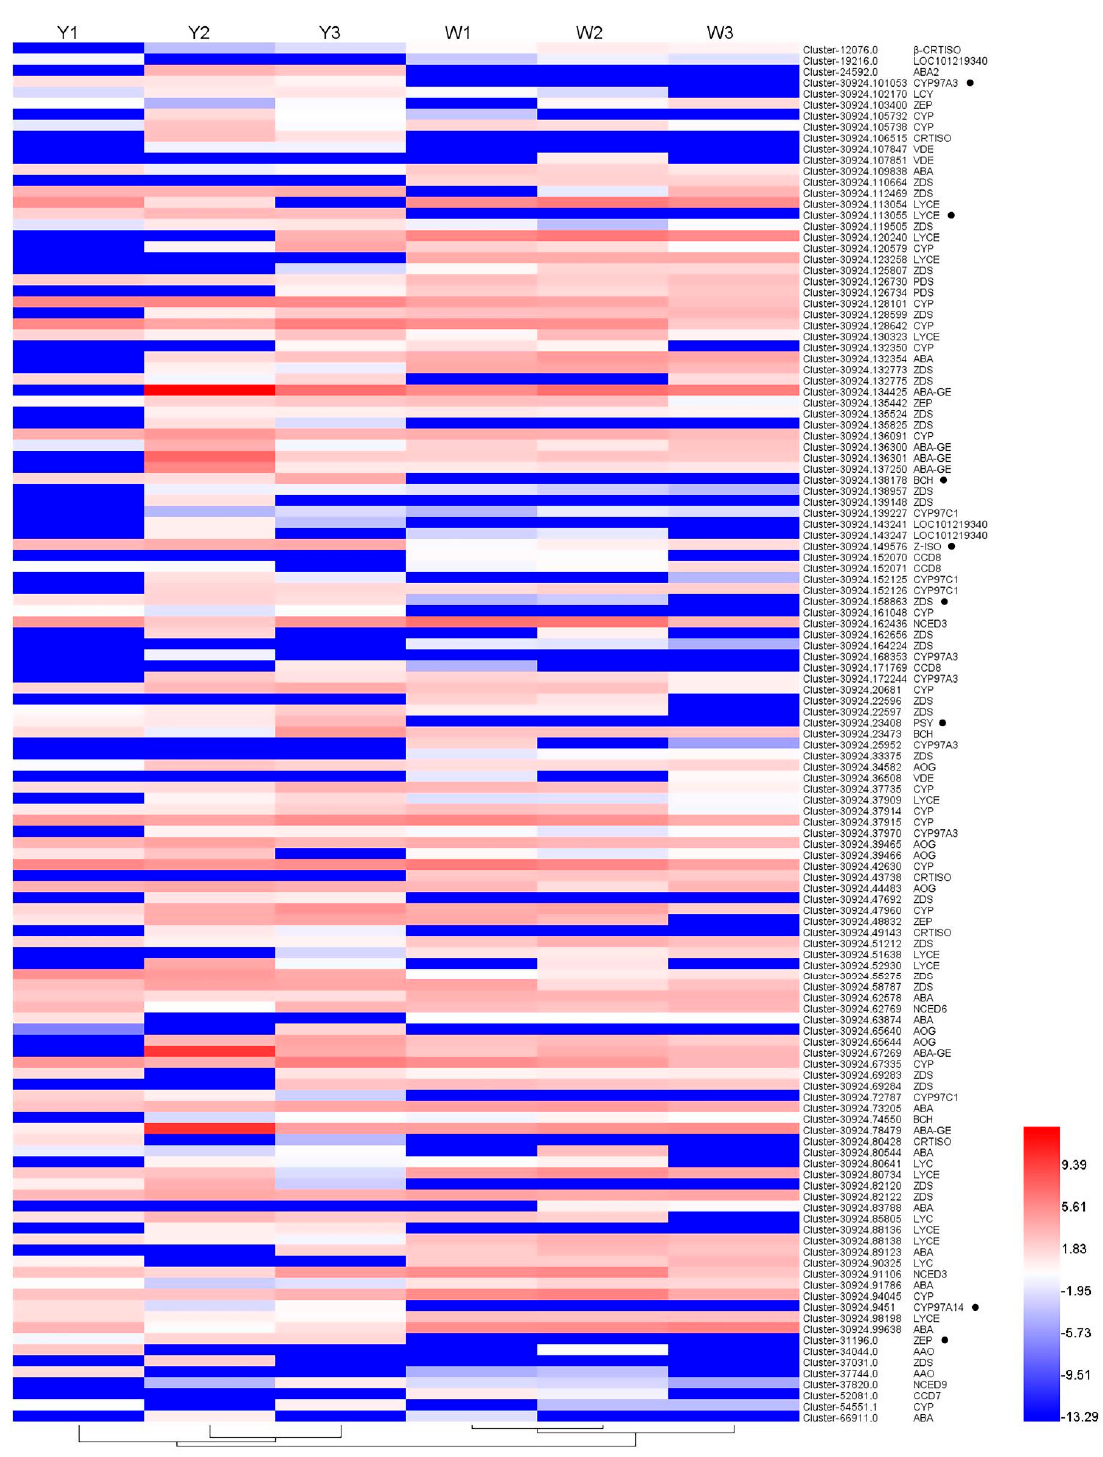
Figure 4. The Log 2 FPKM heatmap of 125 differentially expressed unigenes involved in the carotenoid biosynthesis pathways. • indicates differentially expressed unigenes involved in the carotenoid biosynthesis pathways with higher expression level in yellow-fleshed turnip.